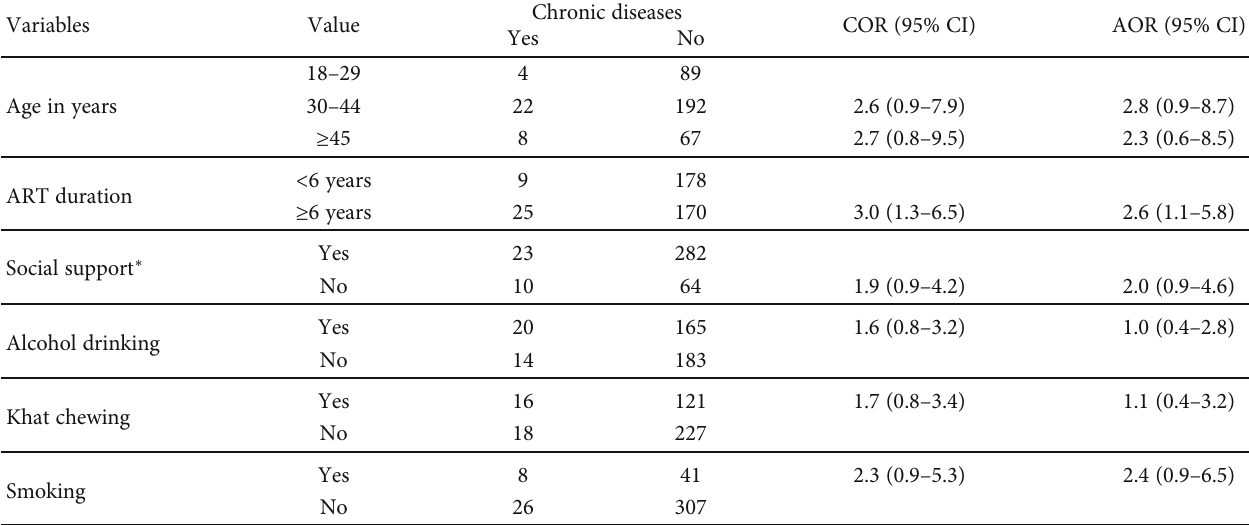
Table 6: Risk factors of multimorbidity among people living with HIV at HUCSH, April